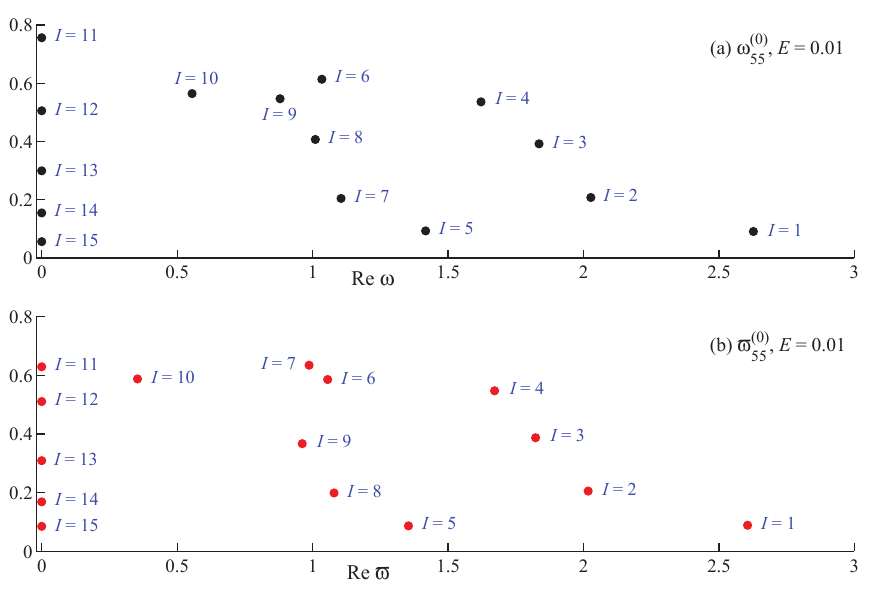
Figure 1. (colour online)The eigenfrequencies ( a ) ω to I corresponds to that in Table 2 and Figure 5. The eigenfrequencies with negative values of (cid:60) ω ( 0 ) and (cid:60) ω , I = 16, . . . ,25, are found by reflecting I = 1, . . . 10 in ( a ) and ( b ) across the vertical axes 55 (cid:60) ω ( 0 ) = 0 and (cid:60) ω ( 0 ) = 55 55